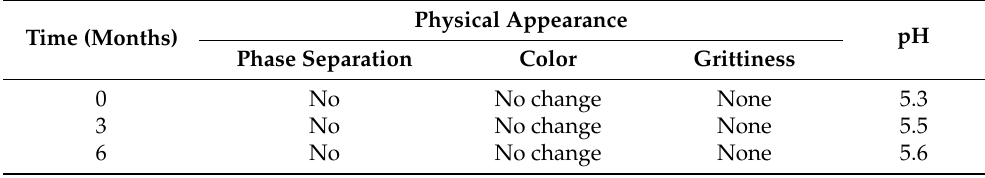
Table 3. Stability studies of hydrogel in terms of physical appearance and pH. Time